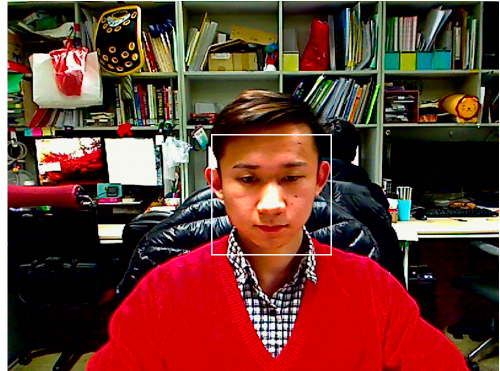
Figure 5. Example of the detected face region ( z -distance: 61 cm, center coordinate of face region: (859, 627)).